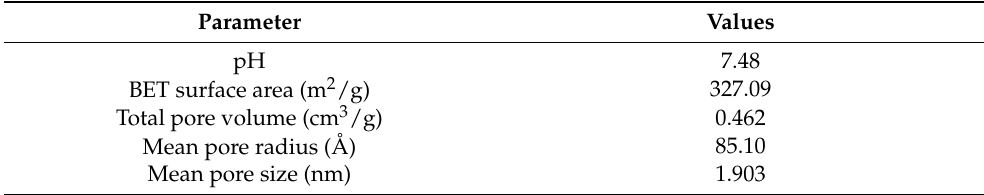
Table 2. HWSB surface and structural